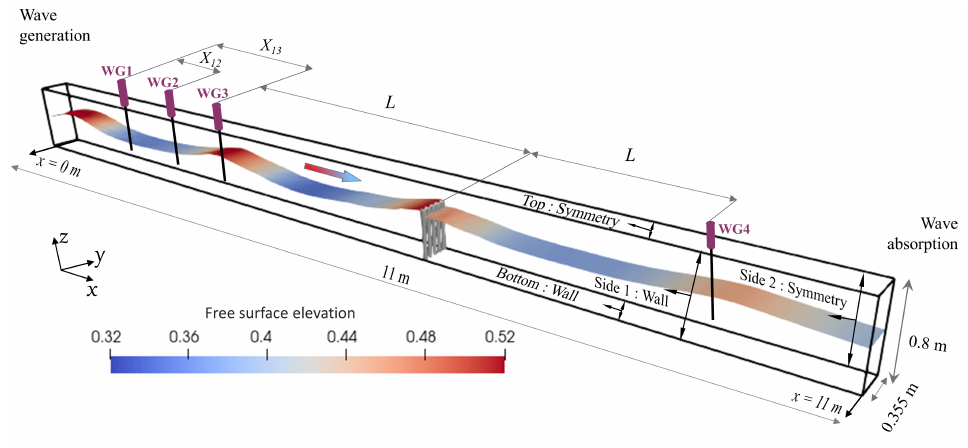
Figure 4. Detailed view of the numerical wave